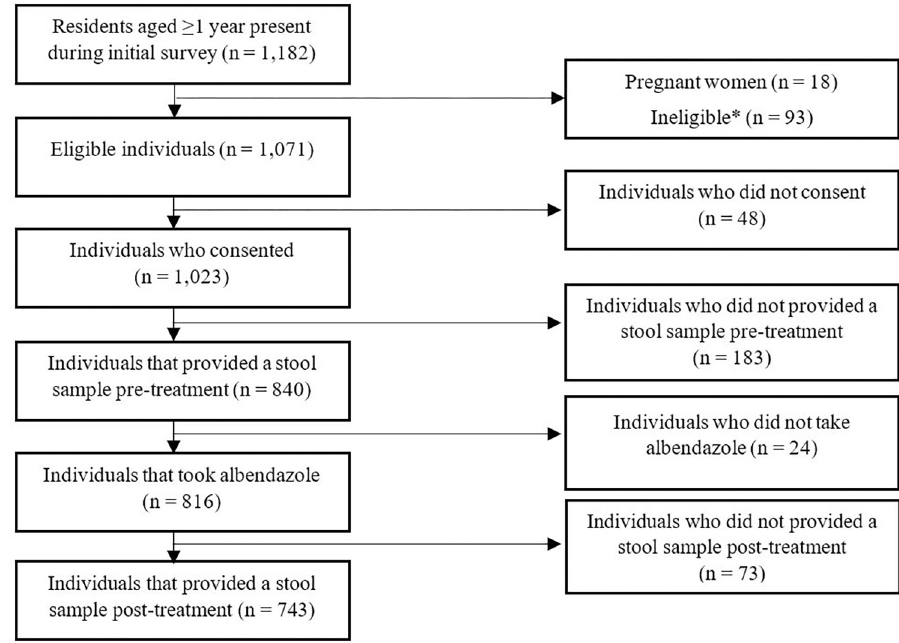
Fig 1. Efficacy study design. � Ineligible due to poor health as determined by the research team.